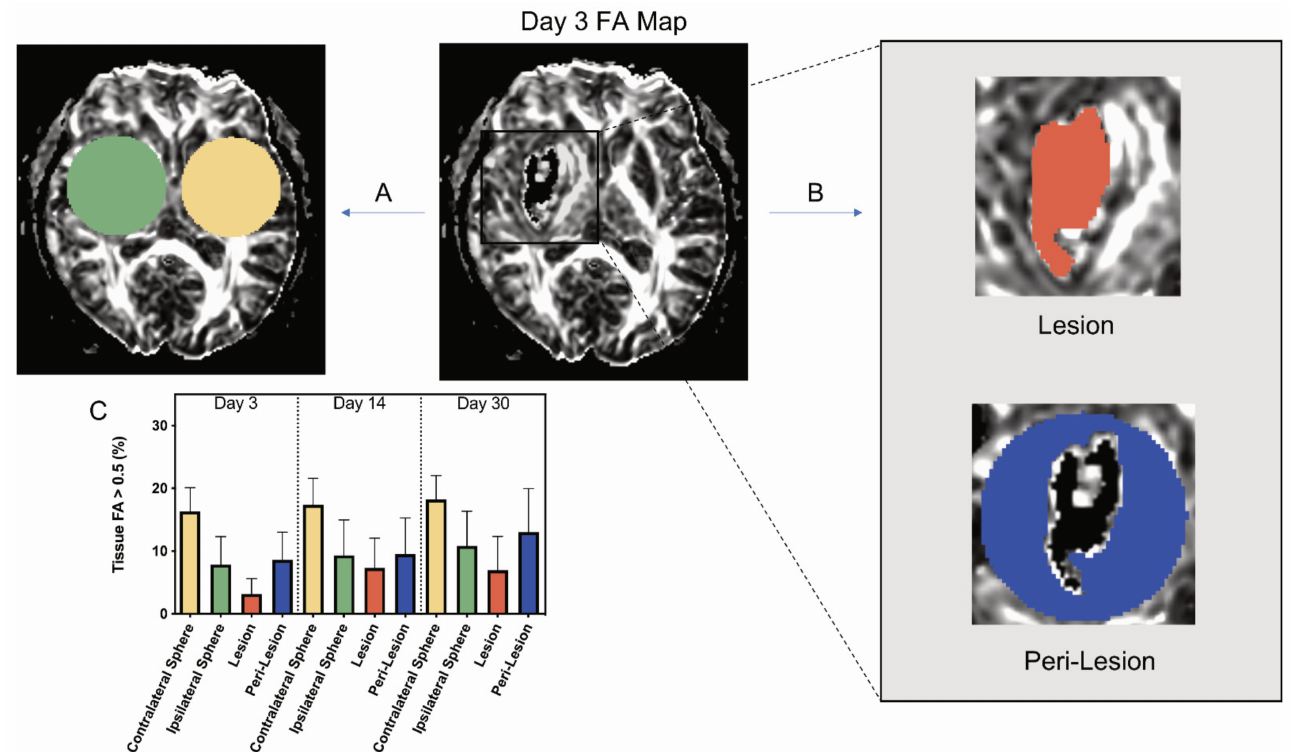
Figure 2. Example of analysis of a day 3 fractional anisotropy (FA) map and changes in the amount of tissue with FA > 0.5 ipsi- and contralateral to the intracerebral hemorrhage in patients at different times. ( A ) On an FA map, a sphere centered on the lesion (green) was analyzed, along with an identical contralateral sphere (yellow). ( B ) The ipsilateral sphere is split into two components, the lesion volume and peri-lesion volume. The lesion volume FA > 0.5 was directly measured, and the peri-lesion volume was calculated using the difference between the ipsilateral sphere and lesion data (see Methods). All FA > 0.5 data were expressed as a percentage of tissue volume. ( C ) Graph showing the percentage of tissue FA > 0.5 for all of these areas of interest at days 3, 14, and 30. Values are means ± SD; n = 9–11. Using a mixed effects model, significant differences were seen by location. All pairwise comparisons for location were significant with p < 0.0001 (Bonferroni adjusted threshold for 6 comparisons = 0.0083) with the exception of ipsilateral sphere vs. peri-lesion ( p = 0.26). There were also improvements over time ( p = 0.0053), but no interaction between location and time ( p = 0.52). (See Supplemental Table S1 for full